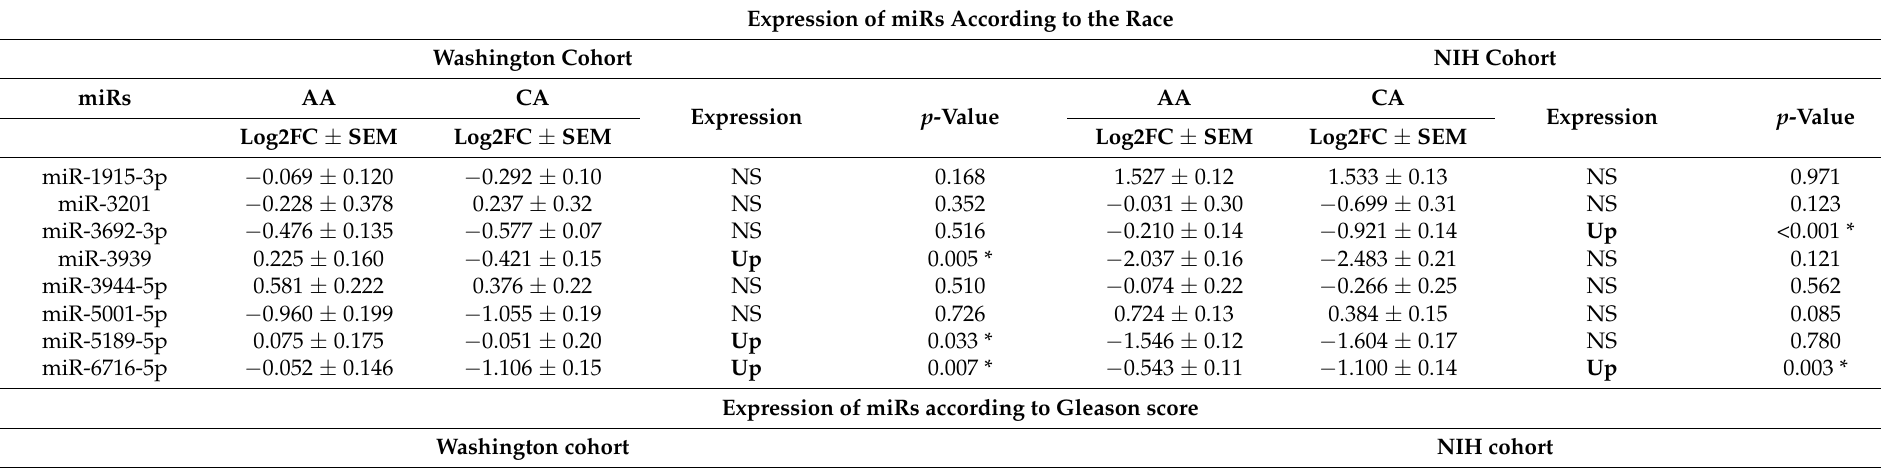
Table 4. Differential expression of miRs in PCa patients based on race and Gleason score. miRs expression was evaluated by qPCR analysis in confirmatory cohorts. Log2 FC of sEV-associated miRs was used to compare the miR expression in AA and CA by Student t-test. Up: upregulated miRs, NS: non-significant miR